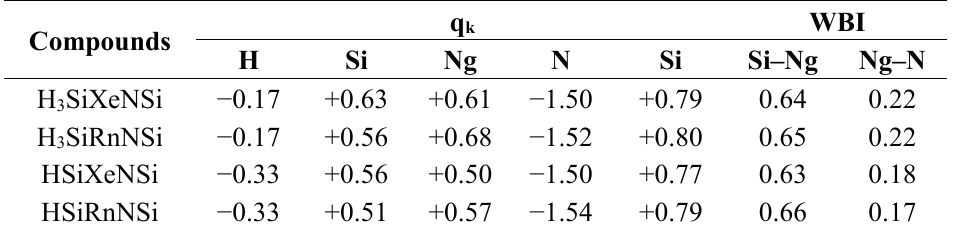
Table 3. Natural population analysis (NPA) charge on each atomic center (q k , au) and Wiberg bond indices (WBI) values of Si–Ng and Ng–N bonds computed at the MP2/def2-QZVPPD level.